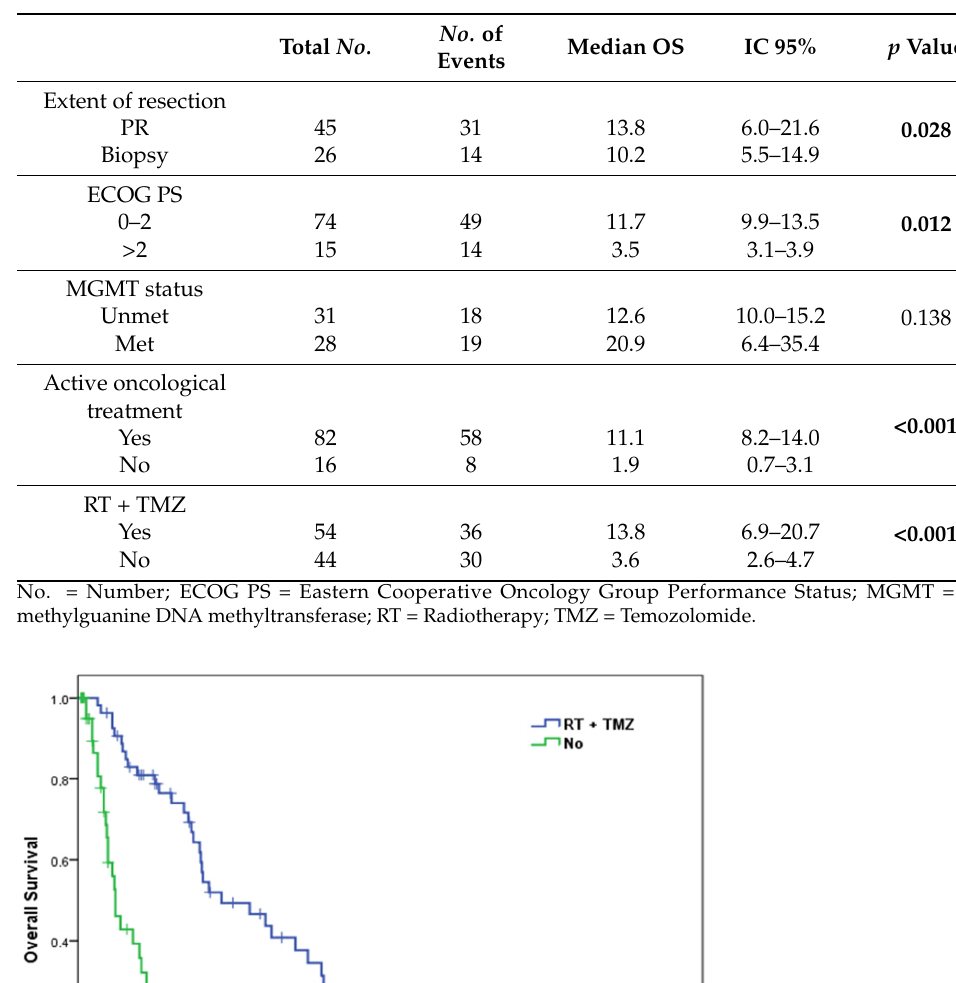
Table 3. Overall survival (OS) analysis using the Kaplan-Meier method and log-rank test.